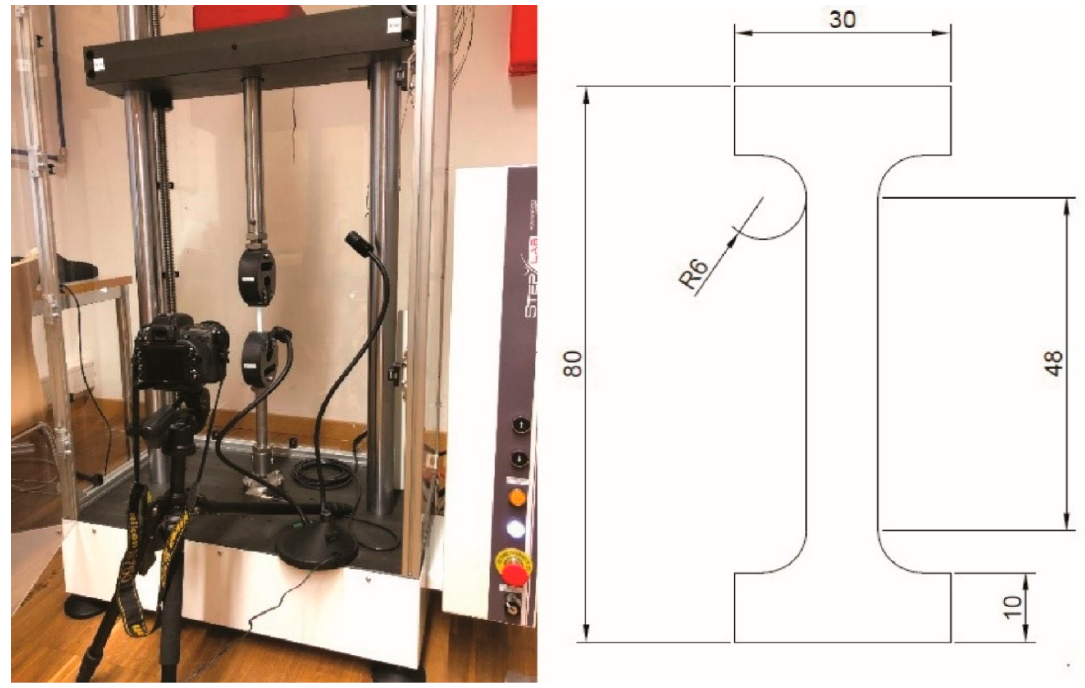
Figure 1. STEPLab UD04 tensile machine and testing setup; (right) dog-bone sample geometry and dimensions.